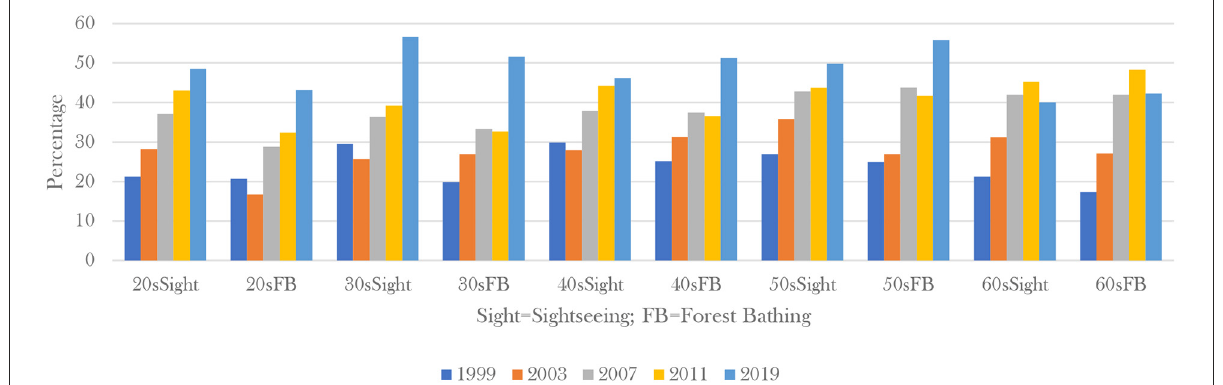
FIGURE2 Comparison of the share of visitors in forests with sightseeing and forest bathing. * In Japan, forest bathing is not only for the purpose of medical care, but also closely combined with tourism. Japan has one of the highest population densities in the world. For many Japanese people, the forest is one of the main places to release the pressure of life and adjust their emotions, so the activity of forest bathing is often with the purpose of leisure play (73).